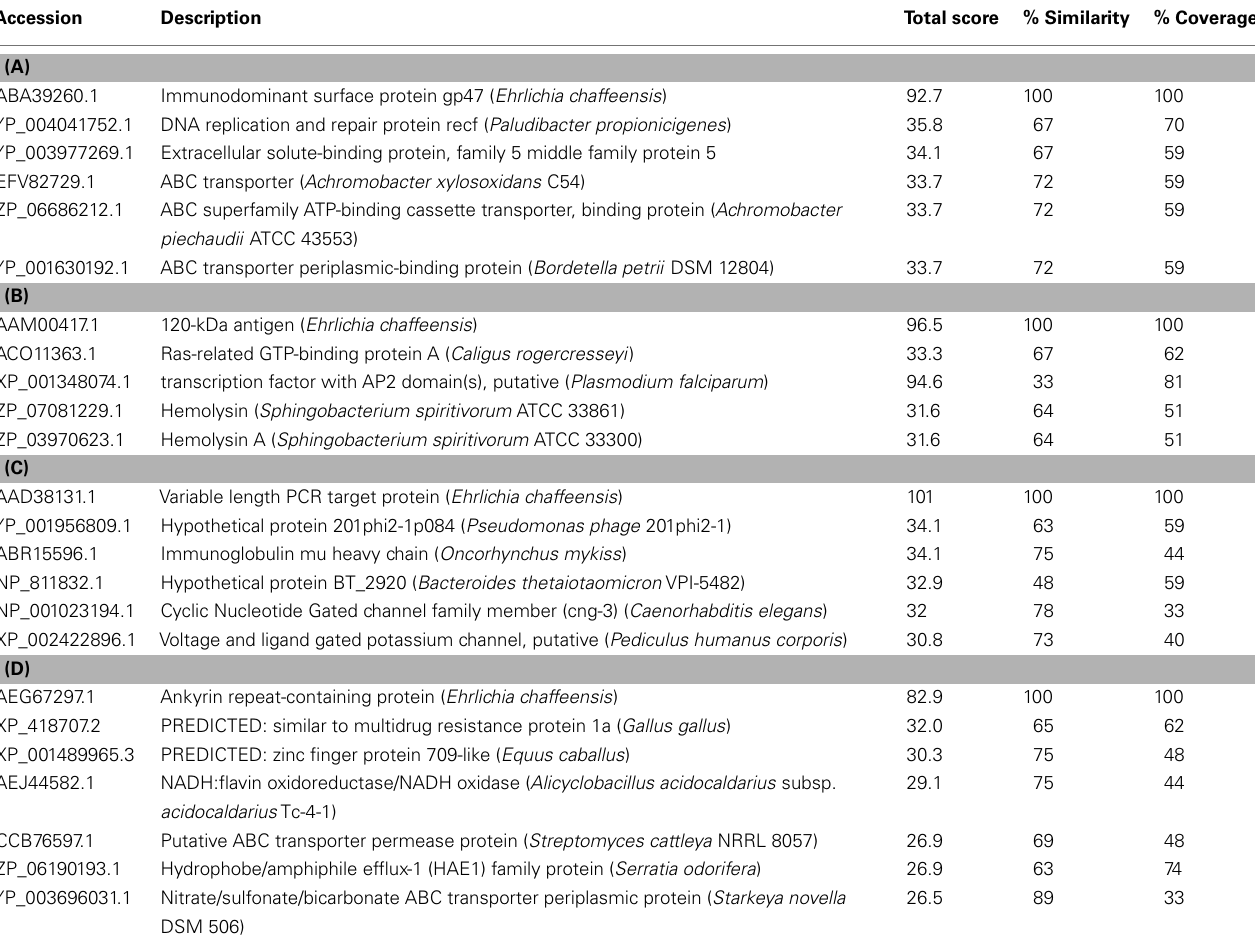
Table 1 | NCBI BLASTP analysis result of C-terminal 27 amino acids of (A)TRP47, (B)TRP120, (C)TRP32, and (D)Ank200 identified homology to type 1 secretion